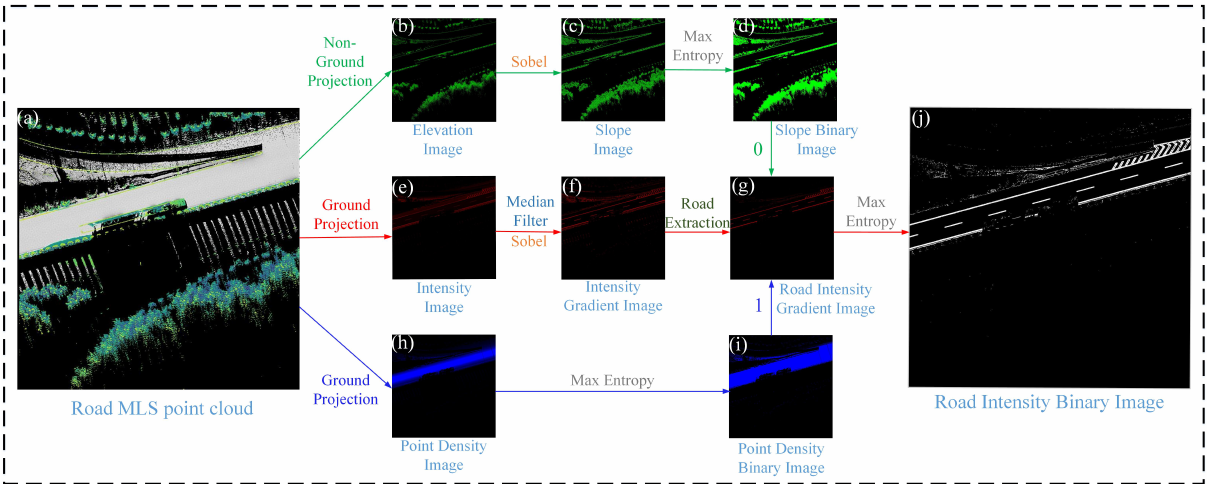
Figure 3. Georeferenced Image Processing, (a) Road MLS point cloud block, (b) Elevation image of non-ground point cloud, (c) Slope image of non-ground point cloud, (d) Slope binary image of non-ground point cloud, (e) Reflectance intensity image of ground point cloud, (f) Intensity gradient image of ground point cloud, (g) Road intensity gradient image, (h) Point density image of ground point cloud, (i) Point density binary image of ground point cloud, (j) Road intensity binary image corresponding to the road markings pixels.